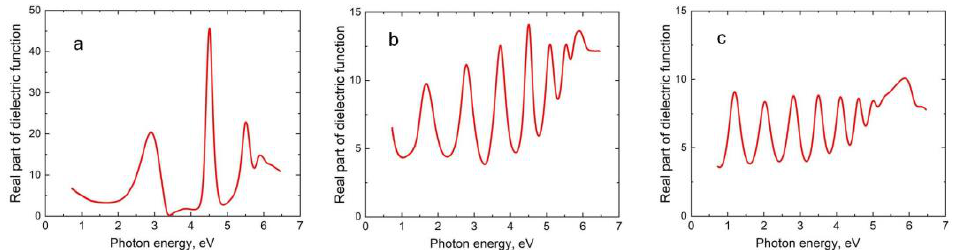
Figure 2. Dependences of the real part of the dielectric constant ε 1 on the photon energy E for three 3C-SiC samples grown on Si(111) substrate doped with B produced at different times of the preliminary Si annealing: ( a )— t a = 0 min, ( b )— t a = 2 min, and ( c )— t a = 5 min.